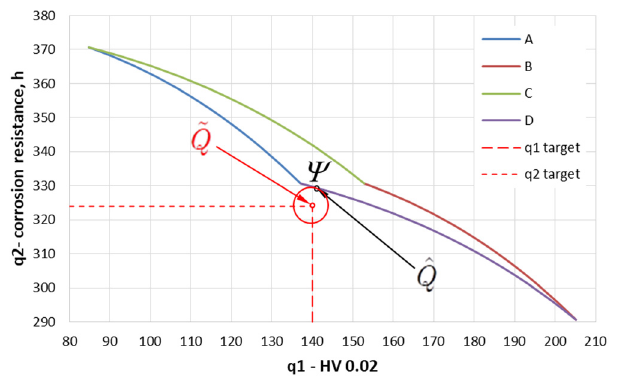
Figure 8. Set of acceptable criteria values.